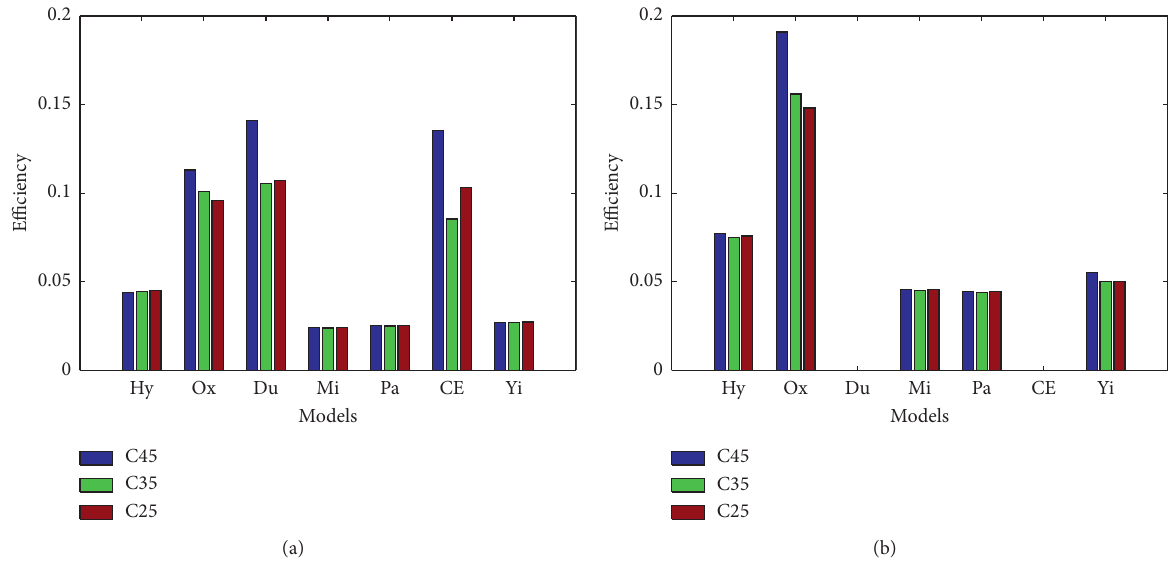
Figure 7: Efficiency of each concrete carbonation model when applied to concretes C45, C35, and C25 for structure A (a) and for structure B